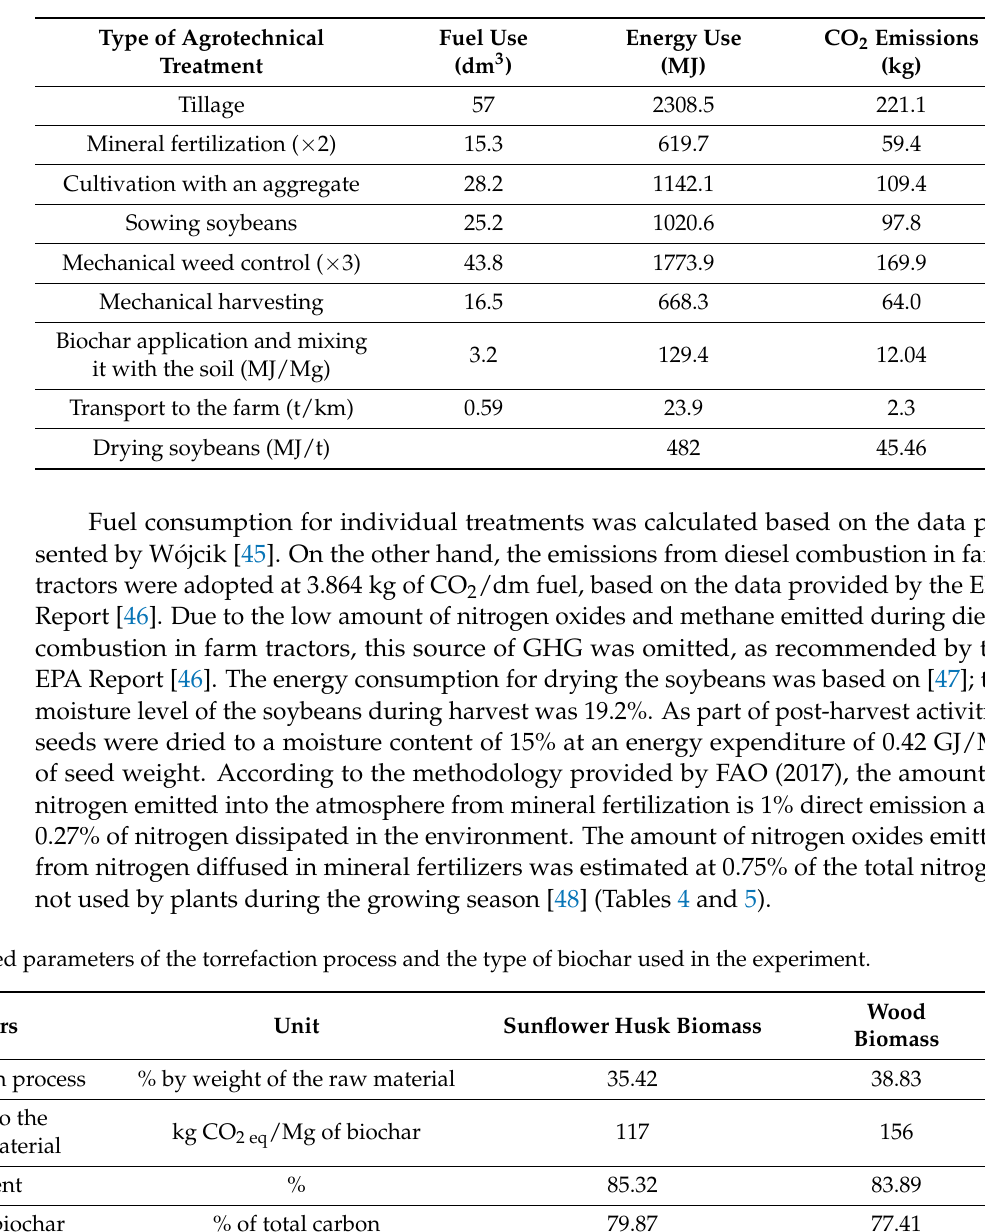
Table 4. Selected parameters of the torrefaction process and the type of biochar used in the experiment. Following Parameters Unit Sunflower Husk Biomass Efficiency of the torrefaction process % by weight of the raw material preparation of the raw